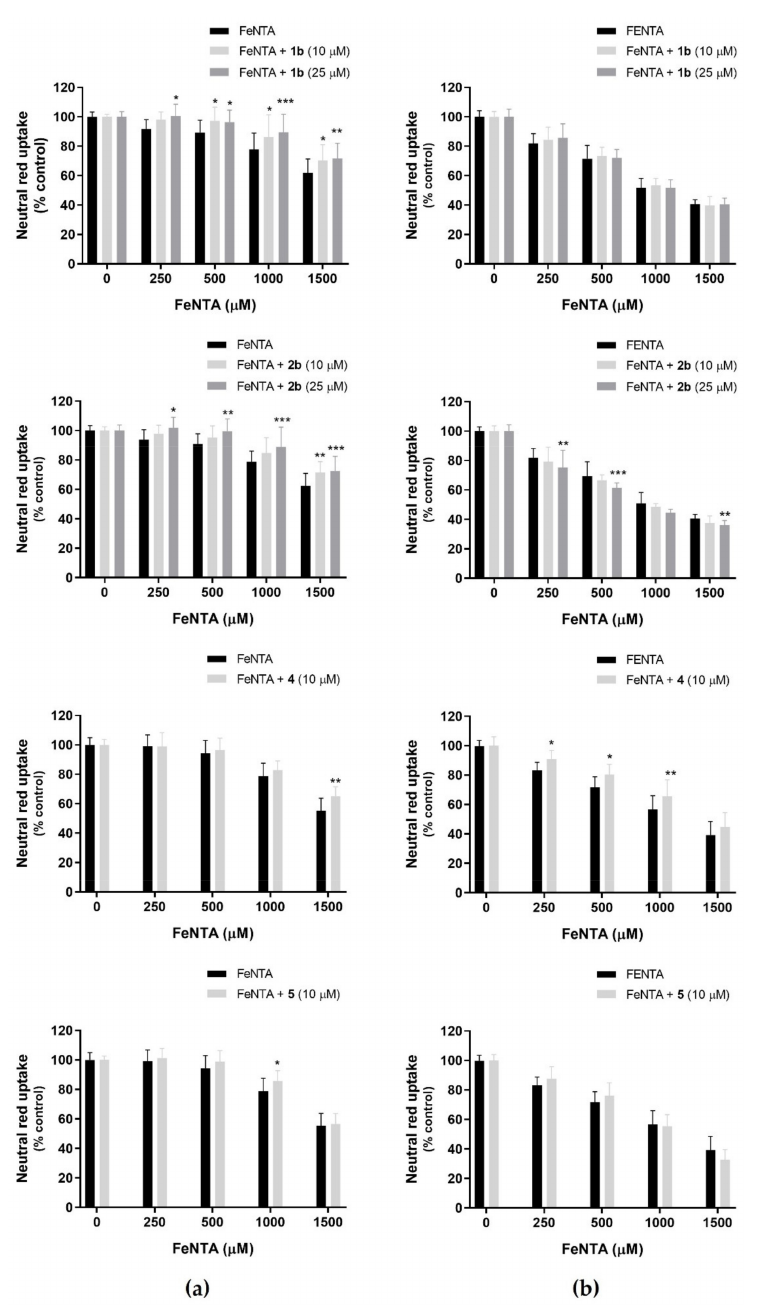
Figure 5. FeNTA (0–1500 µ M) cytotoxicity evaluated in differentiated SH-SY5Y cells, in the presence or absence of the most promising fiscalins ( 1b , 2b , 4 and 5 ) (10 and 25 µ M), evaluated by the neutral red uptake assay, 24 ( a ) and 48 h ( b ) after exposure. Results are presented as mean ± SD from 4 independent experiments, performed in triplicate. Statistical comparisons were made using two- way ANOVA, followed by Holm–Š í d á k’s multiple comparisons test. In all cases, p values < 0.05 were considered significant [* p < 0.05; ** p < 0.001; *** p < 0.001 versus FeNTA alone]. Treatment with FeNTA vs. fiscalin concentration interaction (24 h after exposure) for fiscalins 1b : F (8,229) = 1.324, p = 0.2322; 2b : F (8,212) = 1.490, p = 0.1621; 4 : F (4,165) = 2.258, p = 0.0651; 5 : F (4,165) = 1.087, p = 0.3647. Treatment with FeNTA vs. fiscalin concentration interaction (48 h after exposure) for fiscalins 1b : F (8,243) = 0.4560, p = 0.8860; 2b : F (8,250) = 1.098, p = 0.3648; 4 : F (4,149) = 1.568, p = 0.1859; 5 : F (4,154) = 2.854, p =